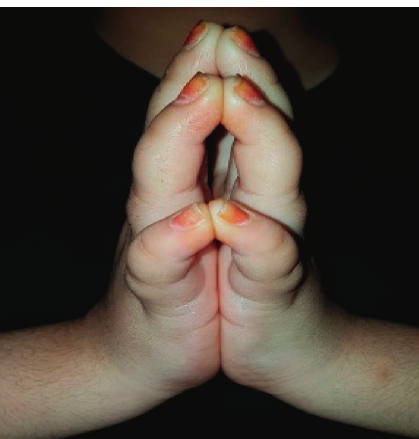
Figure 1: “Prayer” sign showing the significant involvement of the JML of both hands limiting the palmar digits’ alignment on each other. The shiny tight skin over the digits is also